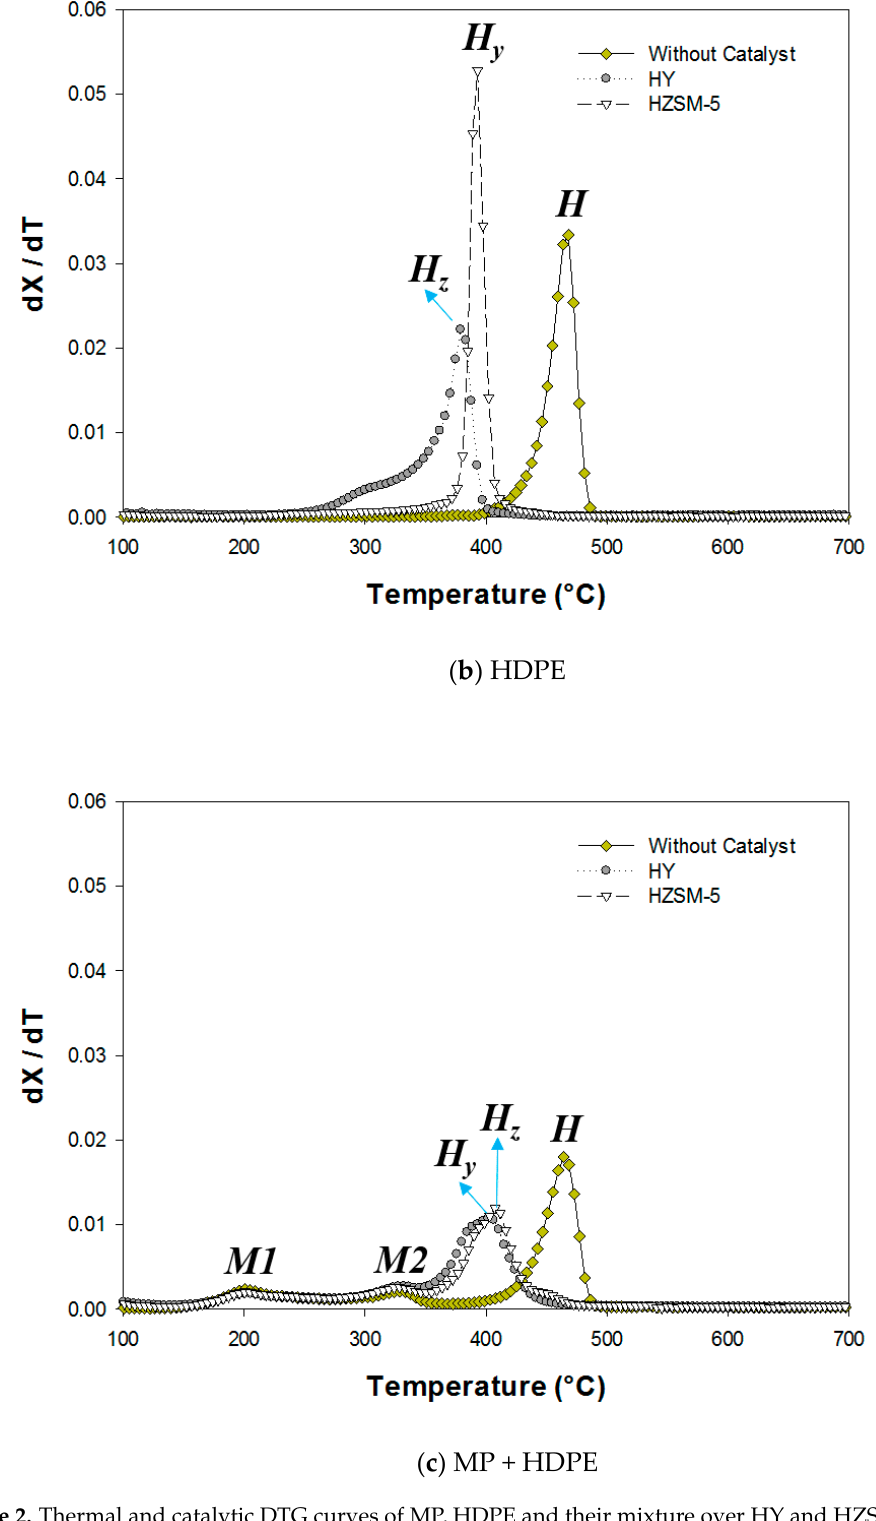
Figure 2. Thermal and catalytic DTG curves of MP, HDPE and their mixture over HY and HZSM-5 at 5 °C/min.